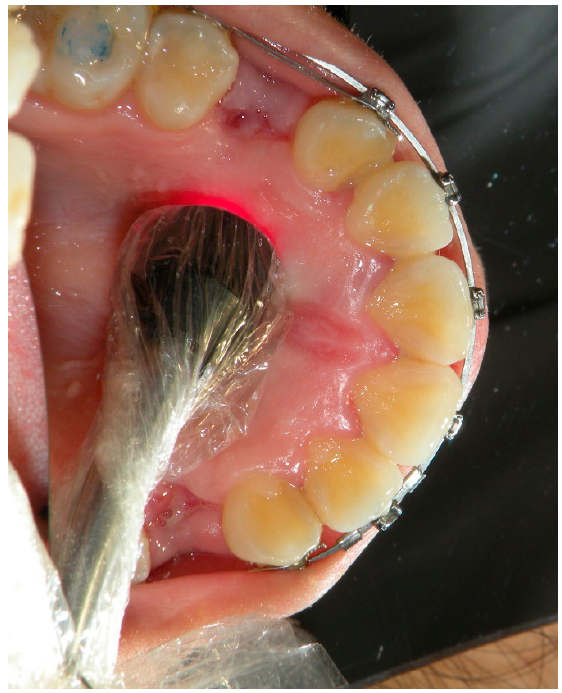
Figure 2. Palatal view of the third apical irradiation of the same canine in Figure 1.